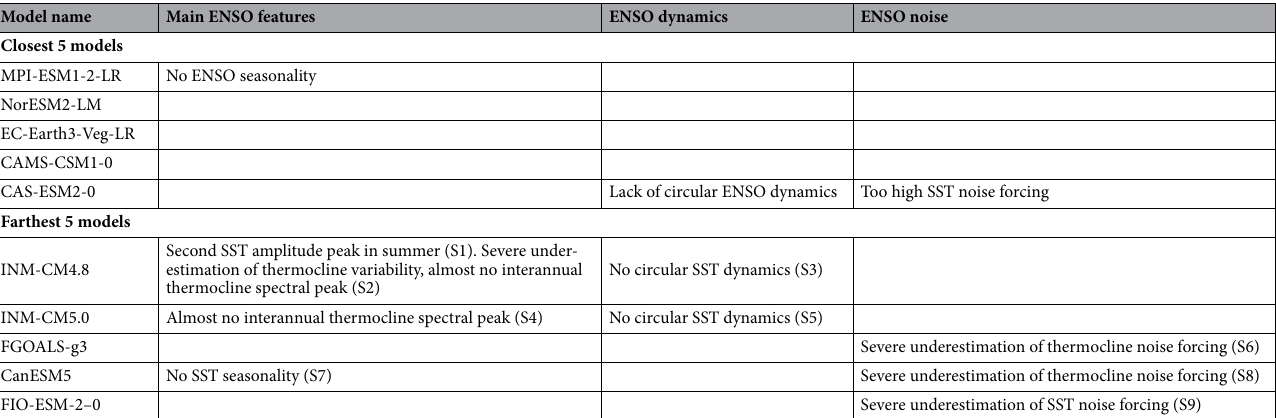
Table 2. Fundamental ENSO issues for two model groups. Fundamental ENSO issues in the five closest and five furthest CMIP6 models, based on symmetric Kullback–Leibler divergences. The references for Supplementary Figs. supporting the findings for the furthest five models are provided in